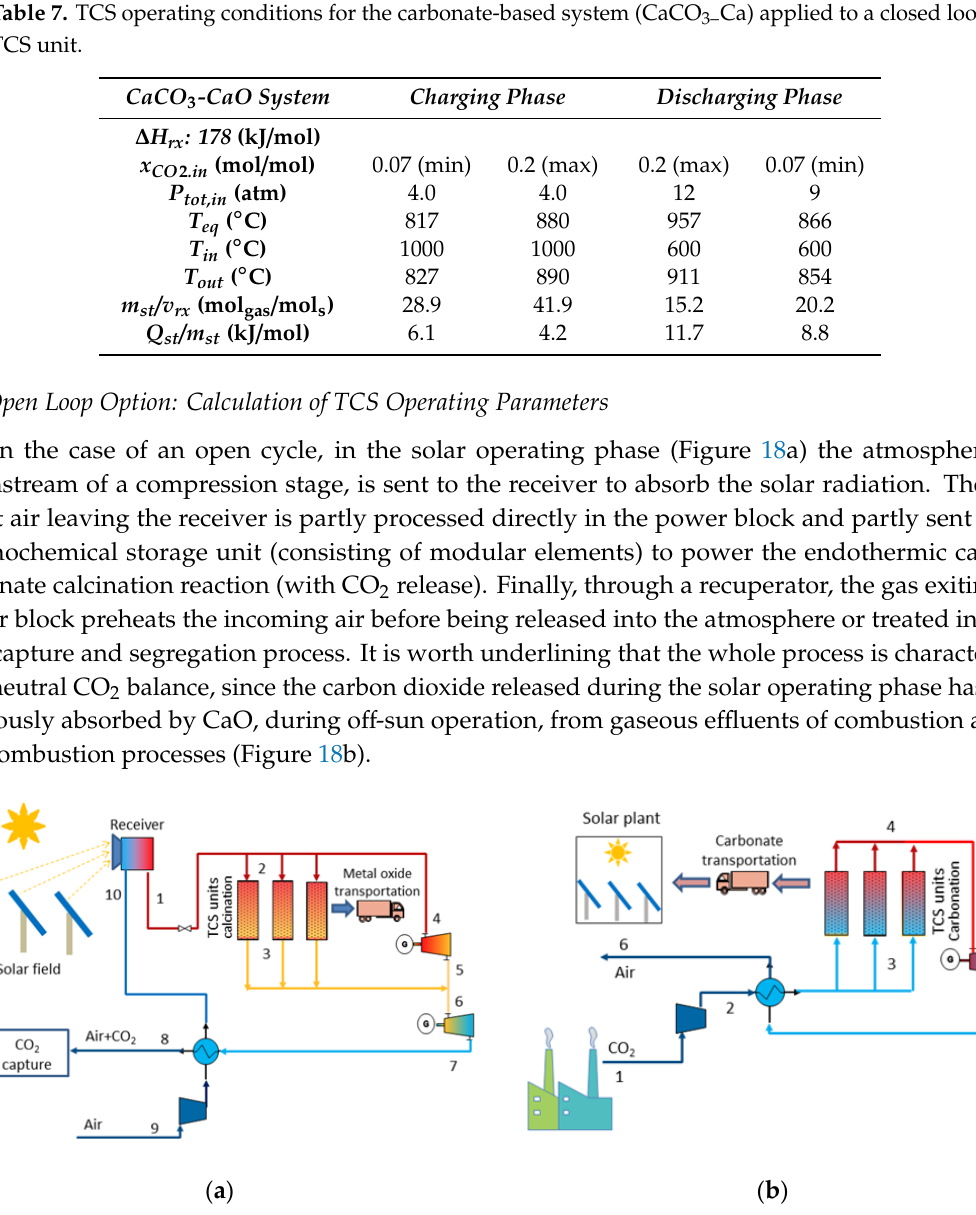
Figure 18. Conceptual scheme for the integration of central tower plant and TCS storage unit assuming adiabatic reactor, open process configuration, Brayton cycle-based power block. ( a ) on-sun operation; ( b ) off-sun operation.